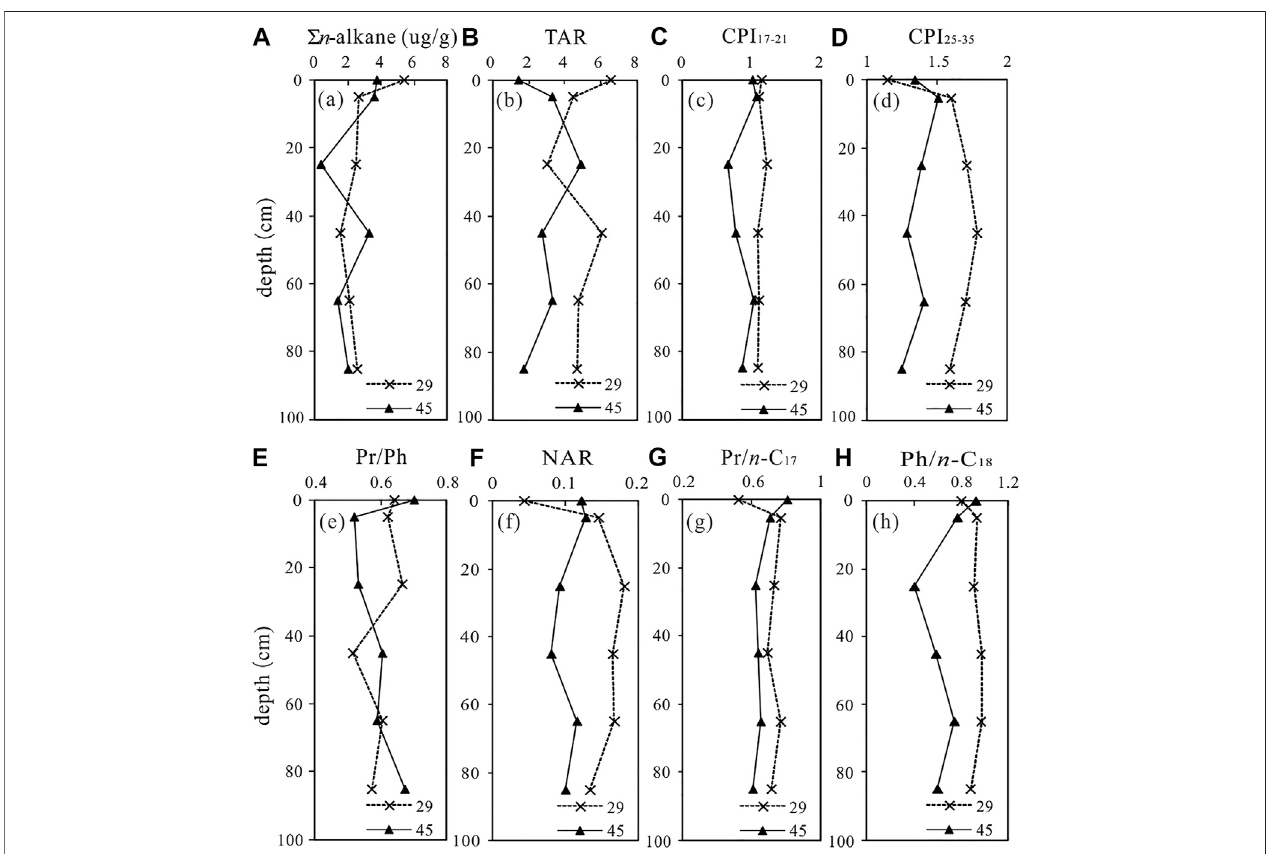
FIGURE4| Depthpro fi leofparameterscalculatedformn-alkanesandisoprenoidsincore29andcore45. (A) total n -alkanesconcentration, (B) TAR, (C) CPI 17 – 21 , (D) CPI 25 – 35 , (E) Pr/Ph, (F) NAR, (G) Pr/ n -C 17, and (H) Ph/ n -C 18 .